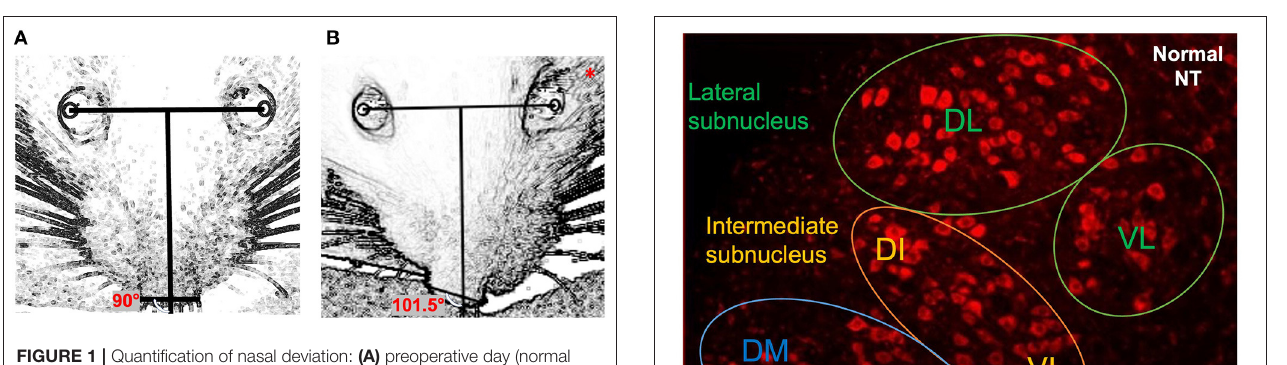
FIGURE 1 | Quantification of nasal deviation: (A) preoperative day (normal nasal position); (B) one day after surgery (left side); * side on which surgery was performed. The angle between the perpendicular line with the interpupillary horizontal line and the line connecting the two nostrils was used for quantification.